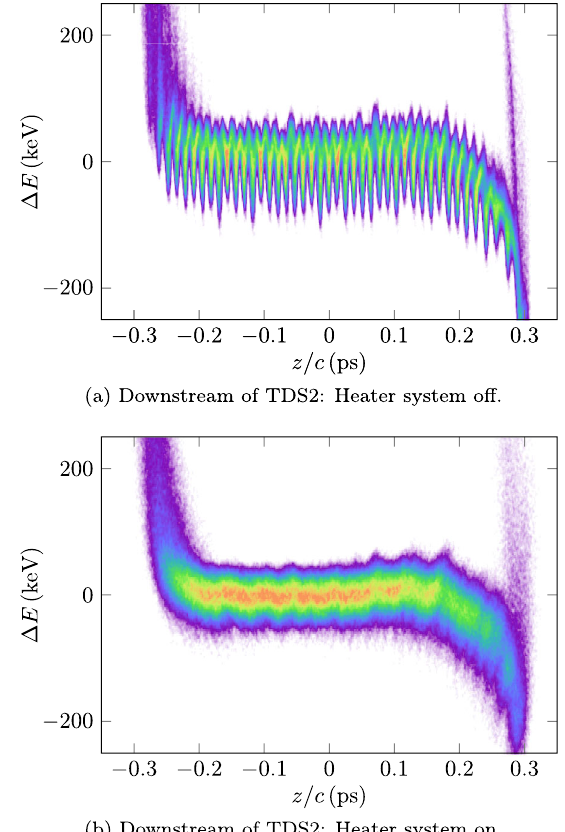
FIG. 8. Simulation on suppression of microbunching instabil- ities due to an initial energy modulation, i.e., simulating longi- tudinal space charge driven microbunching. For the sake of clarity, only the core of the longitudinal phase space, after removing the correlated energy chirp, is